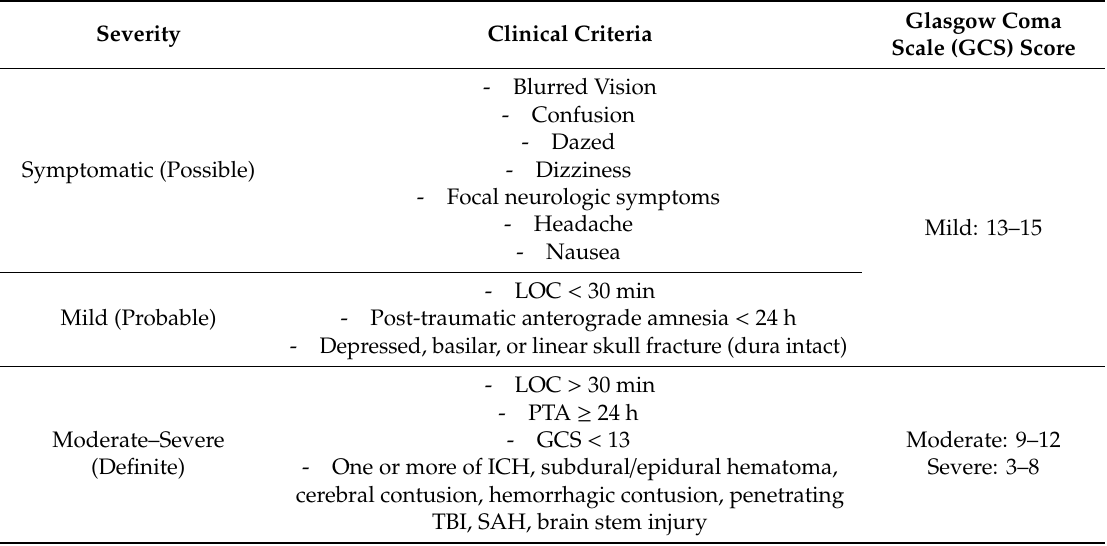
Table 1. Summary of Mayo Clinic classification of traumatic brain injury (TBI) severity, adapted from [7], and Glasgow Coma Scale (GCS) classification for TBI, adapted from [9]. LOC, loss of consciousness; PTA, post-traumatic amnesia; GCS, Glasgow Coma Scale; ICH, intracranial hemorrhage; SAH, subarachnoid